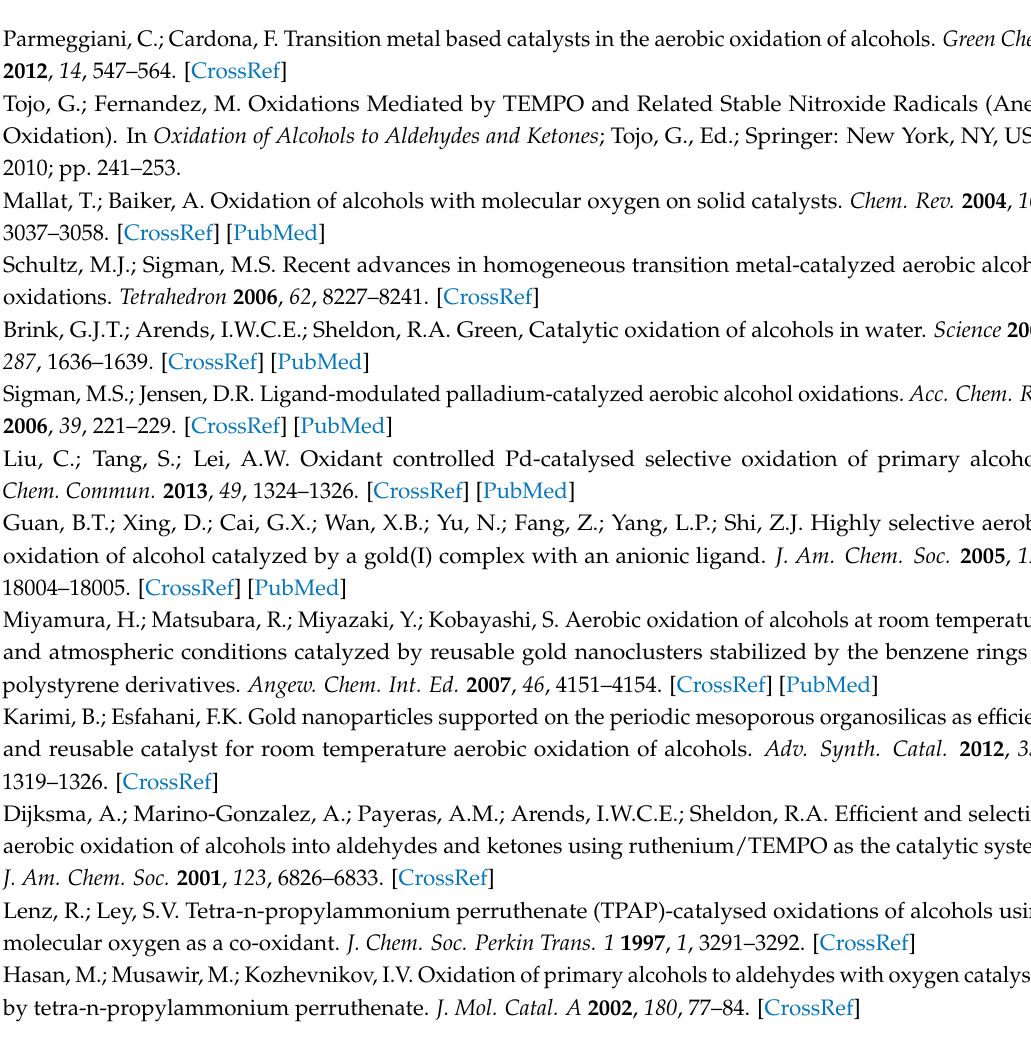
Table S1A: Comparison of the energy barriers for processes 1 7 → 1 TS 7–8 and 2 13 → 2 TS 13–14 between the optimized structures in the gas phase and the solvent; Table S1B: Comparison of energetic spans ( δ E ) for path A and path B at different levels of theories; Table S2: Cartesian coordinates of all structures considered in this work (B3LYP level); Table S3: Relative corrections to Gibbs free energies for each reported structures; Figure S1: The calculated Gibbs free energy profiles for path B (cid:48) . The energy values are in kcal/mol; Figure S2: The calculated Gibbs free energy profiles for the process of 7 (cid:48) → 44 . The energy values are in kcal/mol; Figure S3: The calculated Gibbs free energy profiles for the process of 2 13 → 1 15a . The energy values are in kcal/mol; Figure S4: The calculated Gibbs free energy profiles for Path C. The energy values are in kcal/mol; Figure S5: The calculated Gibbs free energy profiles for Path D. The energy values are in